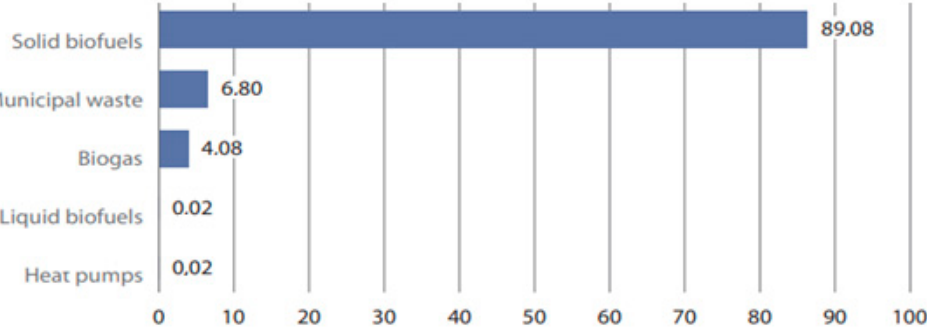
Figure 4. Share of renewable energy carriers in heat production in 2021. Source: Renewable energy in 2021, CSO, Warsaw, 2022.